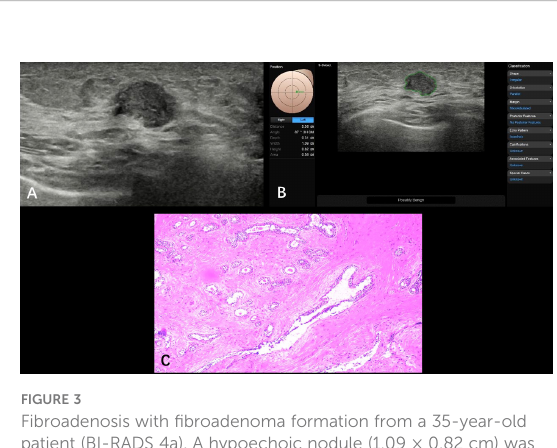
FIGURE 2 Non-speci fi c invasive carcinoma from a 69-year-old patient (BI- RADS 4a). A hypoechoic nodule (0.57 × 0.51 cm) was found at the 2 o ’ clock point of her left breast; the ultrasound graphic showed an uneven edge, irregular shape, and uniform echo (A) . S-Detect arti fi cial intelligence recommendation was “ possibly malignant ” and the BI-RADS score receded from 4a to 4b (B) . Pathologically con fi rmed as breast non-speci fi c invasive carcinoma (C)